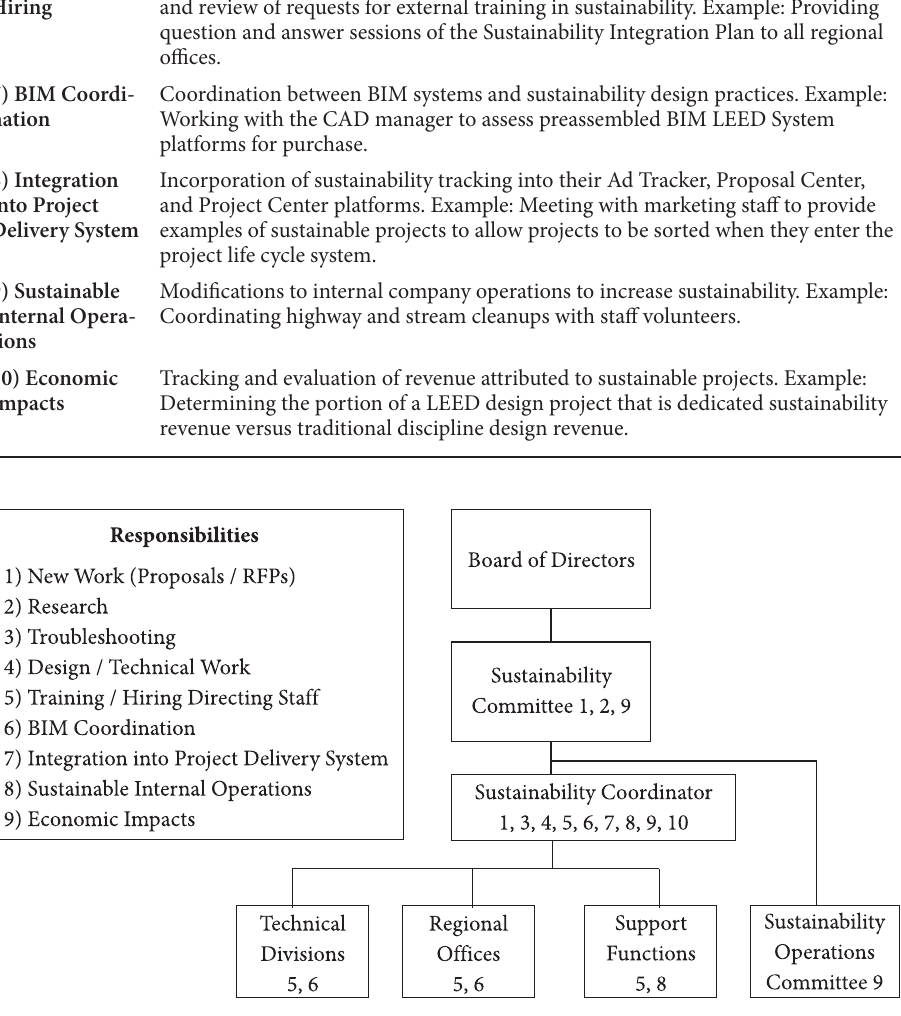
Fig. 1. Project governance